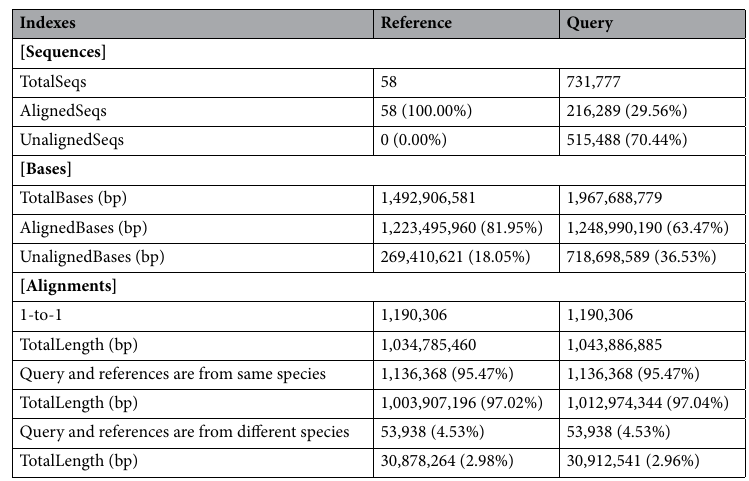
Table 2. Comparison of the concatenated genomes from the two non-hybrid parental species (query) with that of the hybrid individual (reference). The percentages included in the brackets denotes the ratio of the number account for total number.